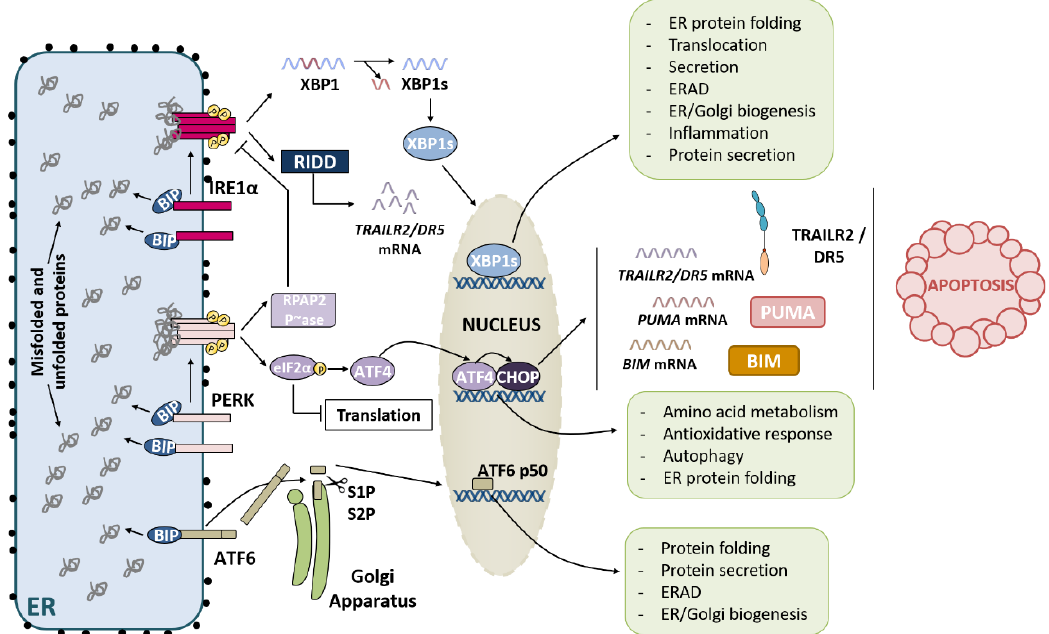
Figure 1. Three ER stress sensors and the induction of the UPR. RIDD: IRE1- α -dependent decay; RPAP2: RNA polymerase II-associated protein 2 phosphatase; S1P: serine protease site-1 protease; S2P: metalloprotease site-2 protease. In mammals, three main stress sensors are found in the ER: Protein kinase RNA (PKR)-like ER kinase (PERK), inositol-requiring protein 1 (IRE1 α / β ) and activating transcription factor 6 α (ATF6 α ). Under unstressed situations, all of them are inactive through the binding to BiP in ER lumen. When improperly folded proteins appear, BiP dissociates from ER stress sensors and binds unfolded and misfolded proteins. BiP dissociation from ER stress sensors allows the activation of the unfolded protein response.